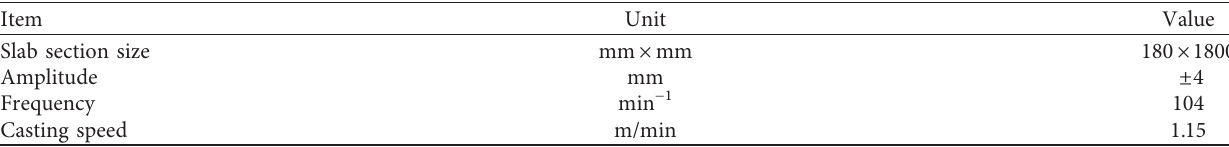
Table 1: Caster parameters.